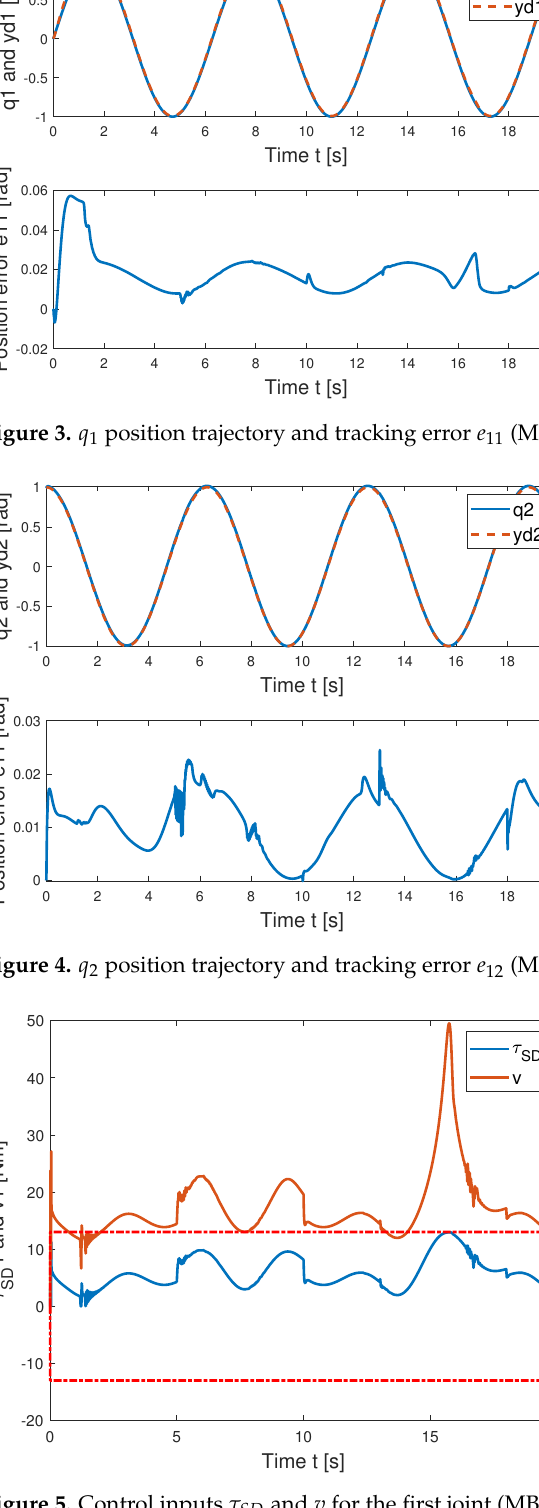
Figure 5. Control inputs τ SD and v for the first joint (MB